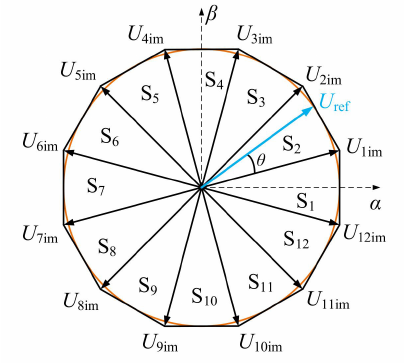
Figure 4. Virtual voltage vector and sector distribution.